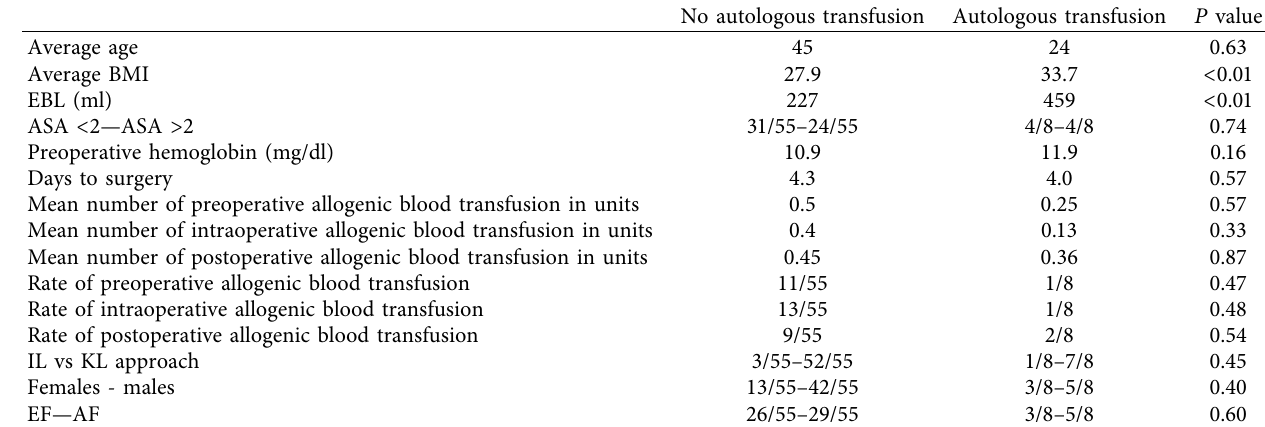
Table 2: Comparison of patients who received autologous blood transfusion to those who did not. Elevated body mass index and higher estimated blood loss were significantly more likely to receive an autologous blood transfusion. There was no association between volume or rate of allogenic blood transfused preoperatively, intraoperatively, or postoperatively in patients who received an autologous transfusion compared to patients who did not. There was no association between surgical approach, gender, or fracture pattern and those receiving an autologous transfusion. IL � Ilioinguinal, KL � Kocher-Langenbeck, ASA � American Society of Anesthesiology Score, BMI � body mass index, EBL � estimated blood loss, EF–elementary fracture pattern, AF � associated fracture pattern.